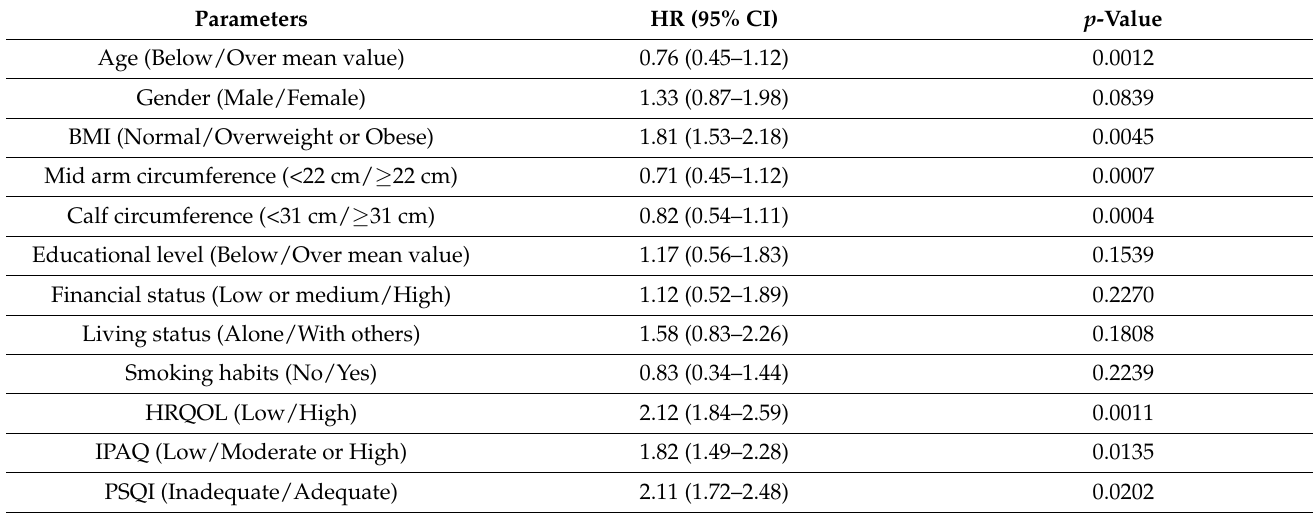
Table 3. Multiple logistic regression analysis for nutritional status after adjustment for potential confounding